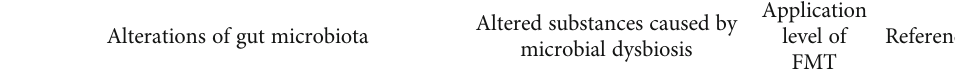
Table 1: Characteristics, consequences, and application level of FMT in neuropsychological